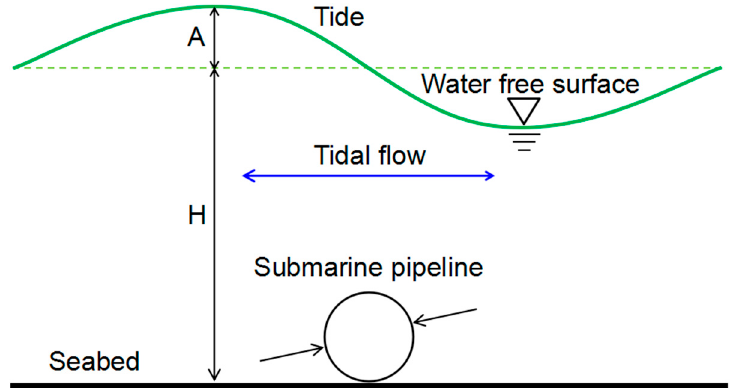
Figure 8. The numerical experimental sketch of f low passing a submarine pipeline .